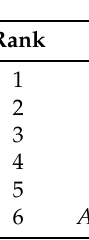
Table 8. Overall Conditional Permutation feature